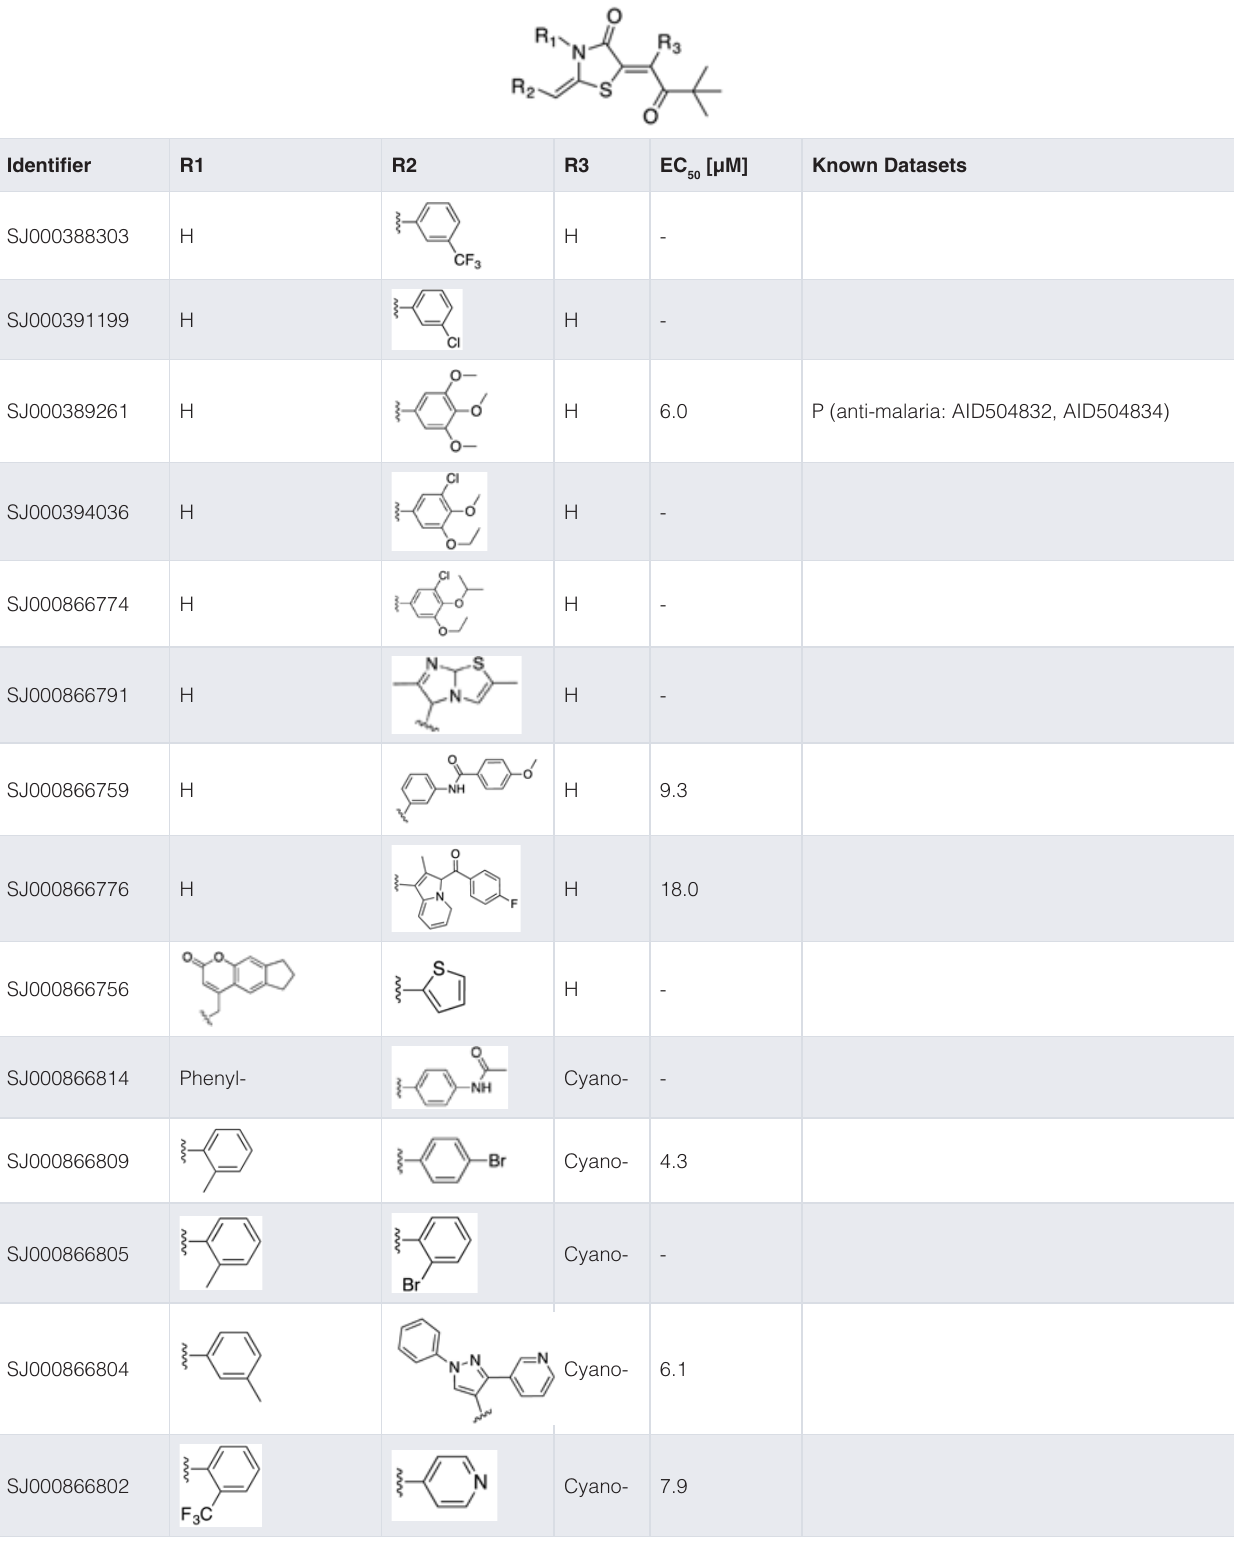
Table 6. The three main scaffolds present in the 73 compounds predicted by Workflow 1. ChEMBL-NTD datasets: Novartis-GNF Malaria Box (N) 40 , St. Jude Children’s Research Hospital Dataset (J) 24 , GSK TCAMS (G) 41 , DNDi HAT set (D). Compounds marked with (P) were tested in PubChem